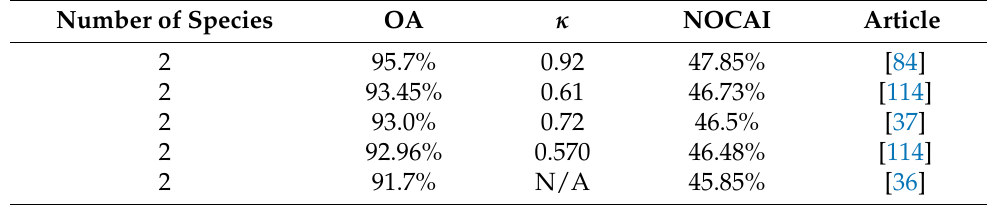
Table A3. List of results of reviewed studies where species classification was performed with a waveform feature group; list sorted by species number and overall accuracy; DM—additional information for studies where trees were delineated